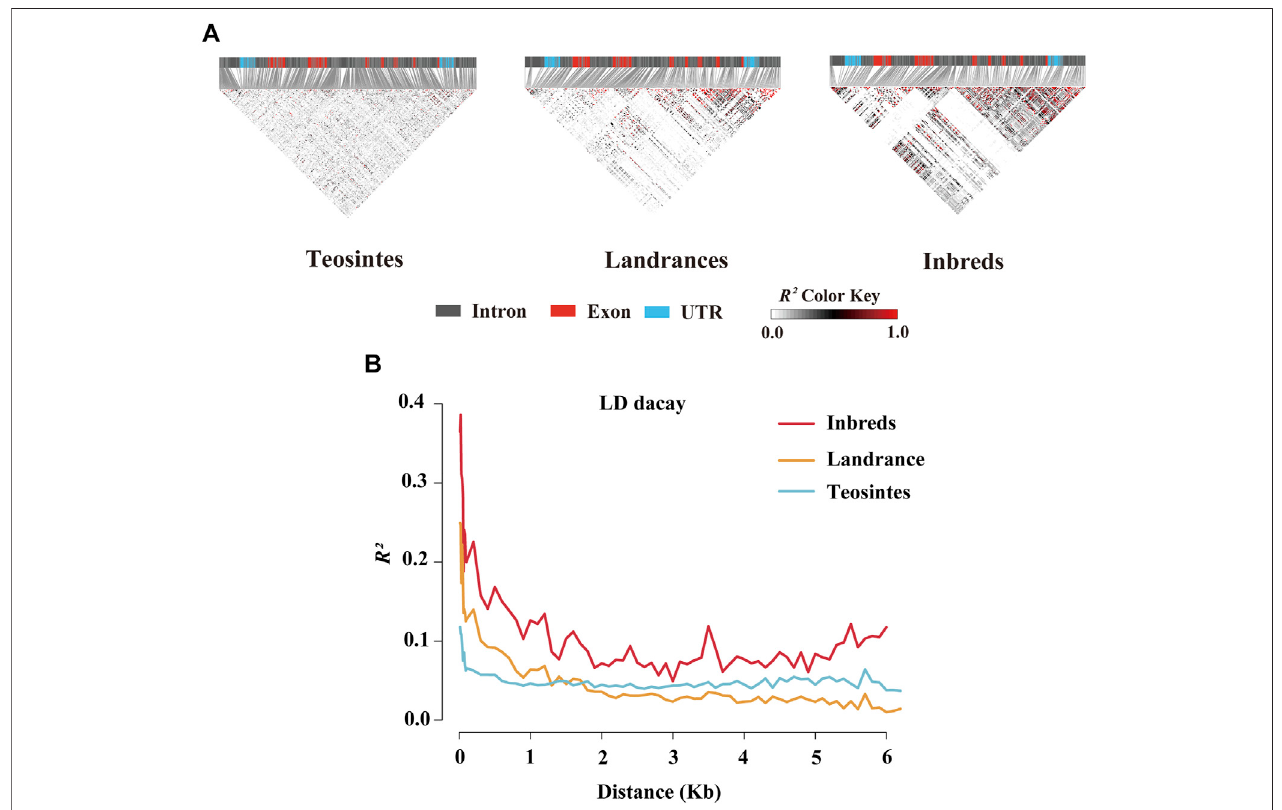
FIGURE 3 | Linkage disequilibrium (LD) analysis of ZmCNR13 gene in three populations. (A) LD model of ZmCNR13 gene in three populations. (B) LD decay for three populations measured by R 2 .